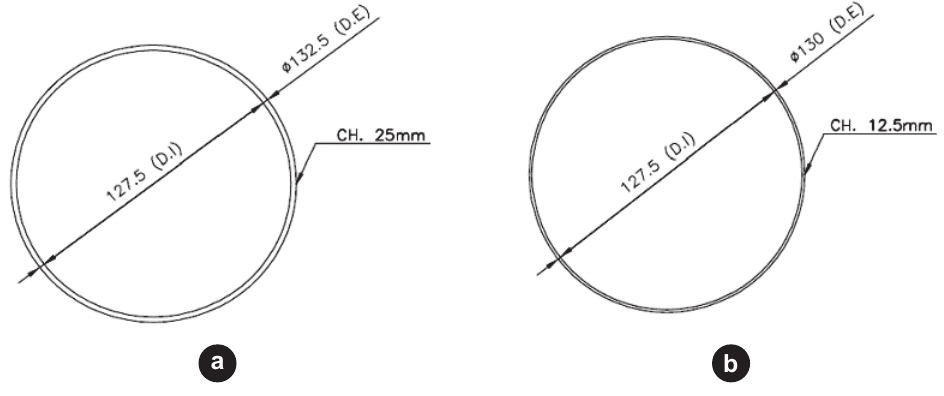
a Cross section of the metal jacket at top (a), middle (b) and bottom (a) of the piles (the dimension is in mm)